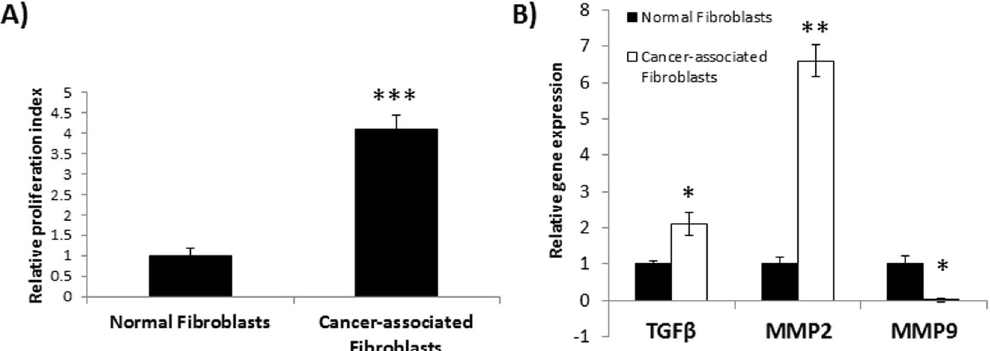
Figure 2. Characterization of normal fibroblasts and cancer-associated fibroblasts in vitro . Primary fibroblast cultures from patients with normal mammary epithelial and cancerous epithelium were obtained and analyzed for differences in proliferation and TGF- β 1, MMP2 and MMP9 gene expression. An MTT proliferation assay was used to determine changes in proliferation in tumor associated fibroblasts (A) . RNA was isolated from replicate cultures and analyzed for TGF- β 1, MMP-9 and MMP-2 gene expression using RT-PCR (B ). * p < 0.05; ** p < 0.01; *** p <